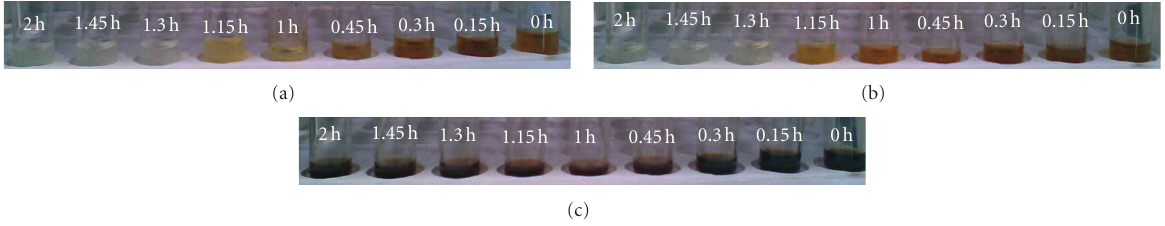
Figure 4: Images of industrial samples treated with BDD applying 2 A ( j = 0 . 32 Acm − 2 ) of current over 2 hours, with constant stirring at pH (a) 1, (b) 7, and (c) 14.